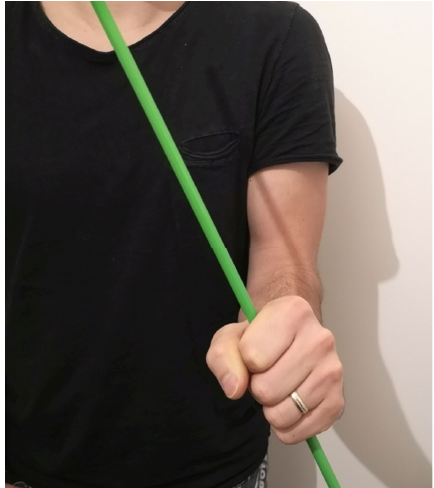
Figure 1. Forearm rotational range of motion where no real supination is possible. When trying to supinate, the result was 20° of pronation (minus 20° of supination).